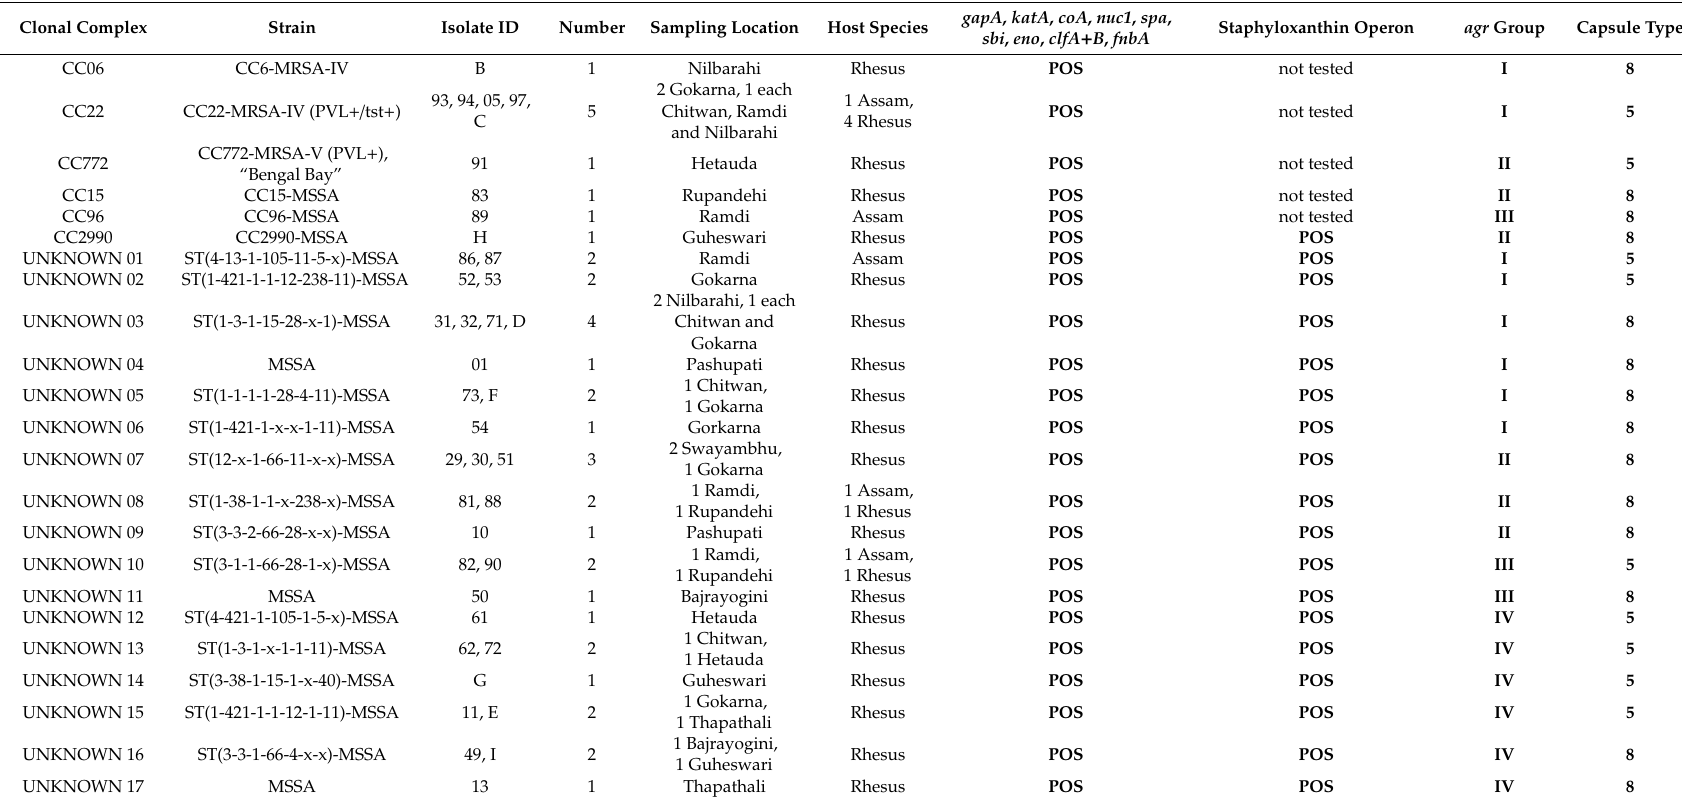
Table 1. Methicillin-resistant S. aureus (MRSA) strains, sample types, and sampling locations as well as species markers, agr groups, and capsule types. Clonal